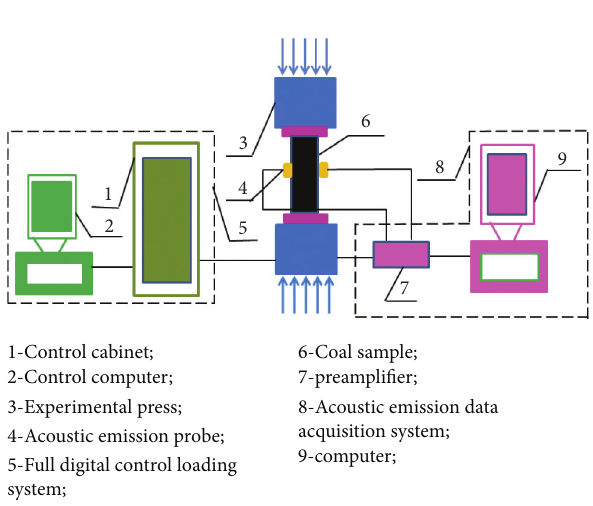
Figure 2: RMT integrated rock mechanics test system.